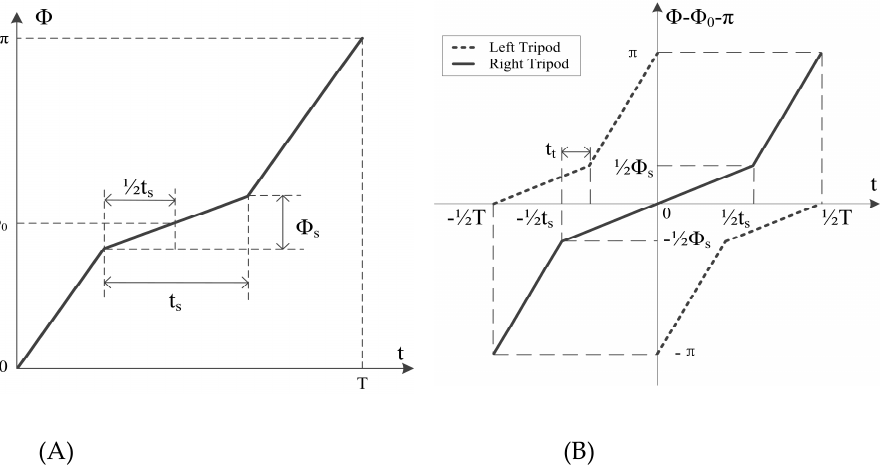
Figure 5. Wheel-leg trajectory planning when moving forward. ( A ) Schematic diagram of the trajectory of a wheel-leg from the initial point; ( B ) expected curve of trajectory planning, where T is the period of a rotation of each foot, and φ is the rotation angle at the corresponding moment. Gait planning is carried out for each foot of the hexapod robot according to the given gait period. The robot can obtain a stable and reliable running gait.